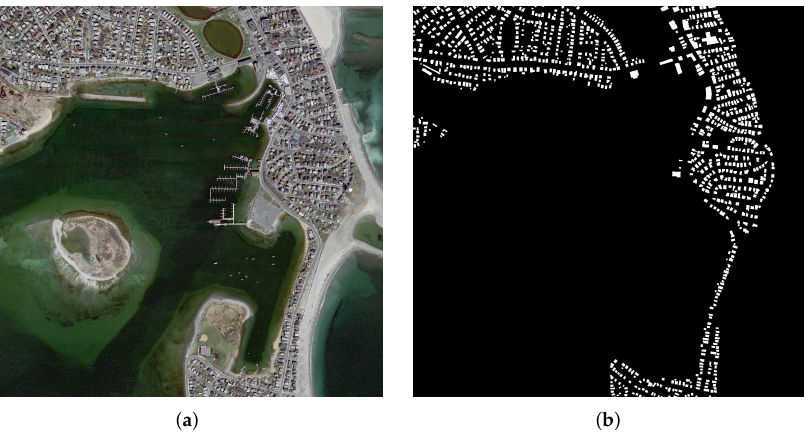
Figure 6. An example of the Massachusetts Building Dataset. ( a ) Original image; ( b ) Ground truth